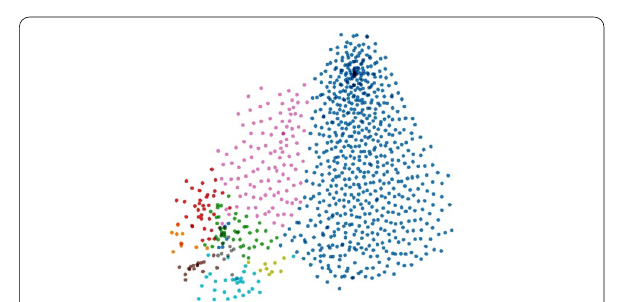
Fig. 4 feature distribution of malicious domain families display